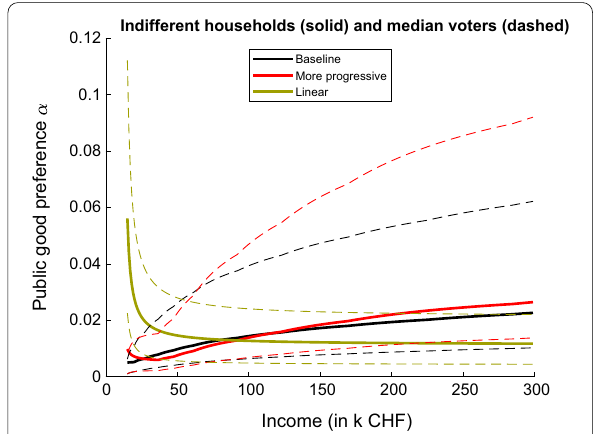
Fig. 5 Changing the progressive tax scheme: effect on the distribution of households (solid lines) and on the loci of indifferent households (dashed